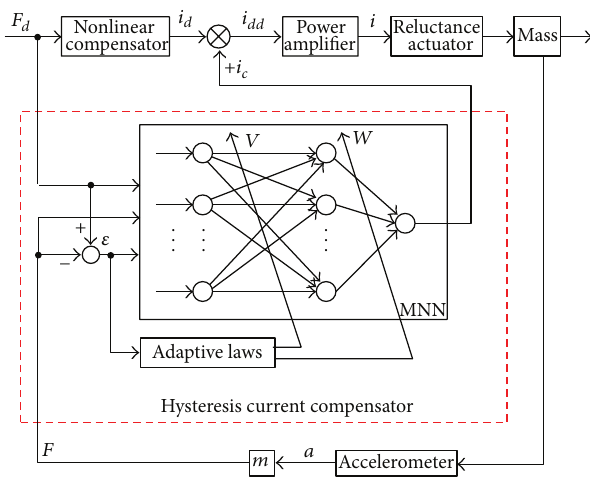
Figure 5: Structure of hysteresis current compensator using adap- tive